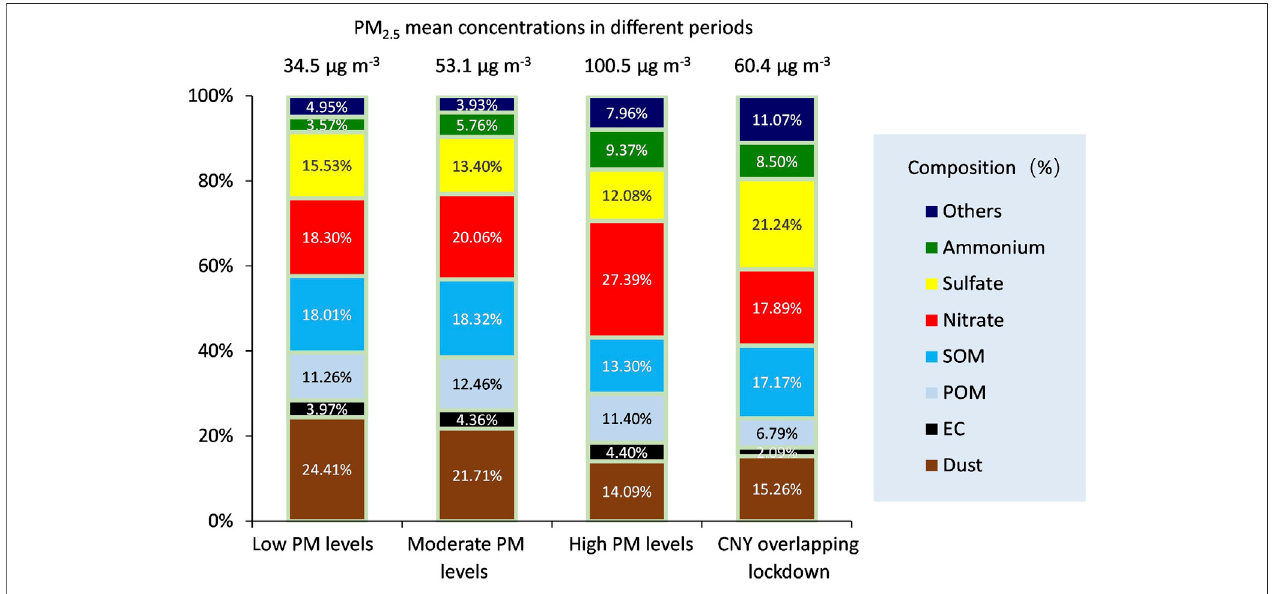
FIGURE4| Material balance during differentPM concentrationlevelperiods.[The campaign wasdivided intothree levels depending on thethreshold values ofthe PM 2.5 concentrations as Low ( ≤ 35 μ g m − 3 ), moderate (35 – 75 μ g m − 3 ) and high ( > 75 μ g m − 3 ) PM concentration levels. And the CNY overlapping lockdown period was separately